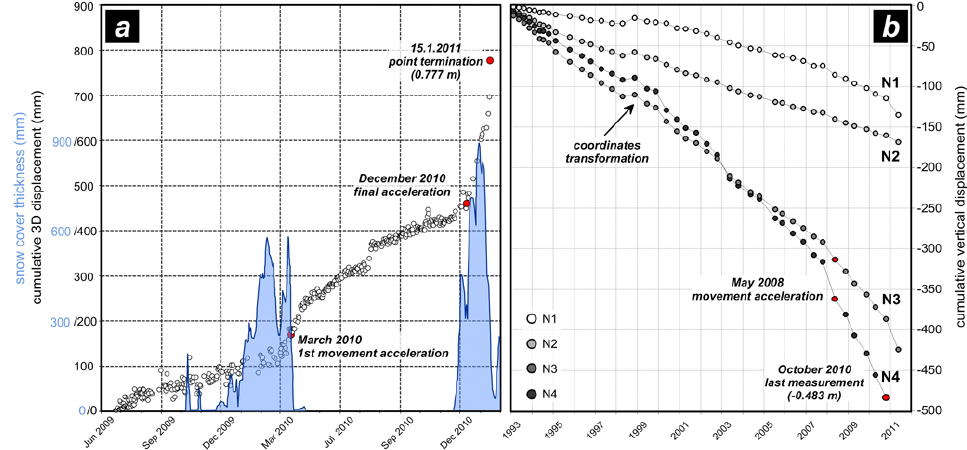
Fig. 8. (A) , a cumulative three-dimensional displacement and snow melting (at NV station) versus time diagram showing the development of the landslide in the two years prior to January 2011. It is clear that there are two cycles of acceleration: the first in March 2010 and the second in December 2010. (B) , a cumulative vertical displacement versus time diagram measured on four niveling bench marks since the